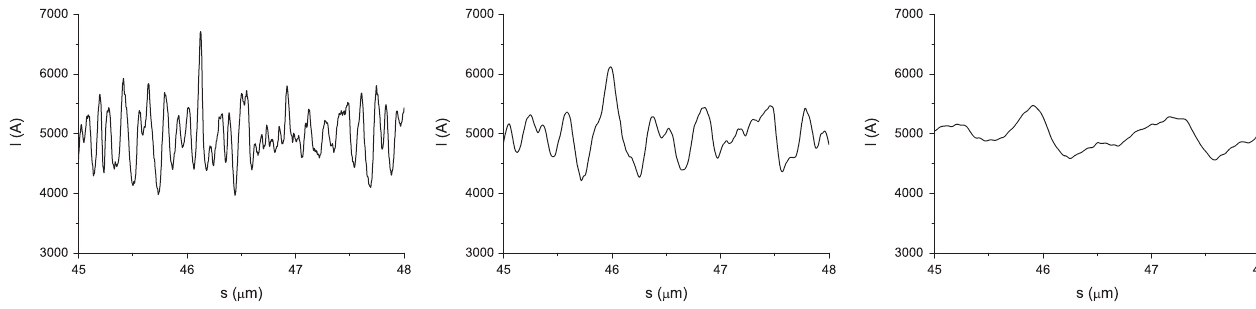
FIG. 5. Modulation of current in the beam passed SASE1 undulator and a dispersion section with R 56 equal to 50 (cid:4) m (left plot, enlarged fraction of Fig. 4), 200 (cid:4) m (middle plot), and 500 (cid:4) m (right